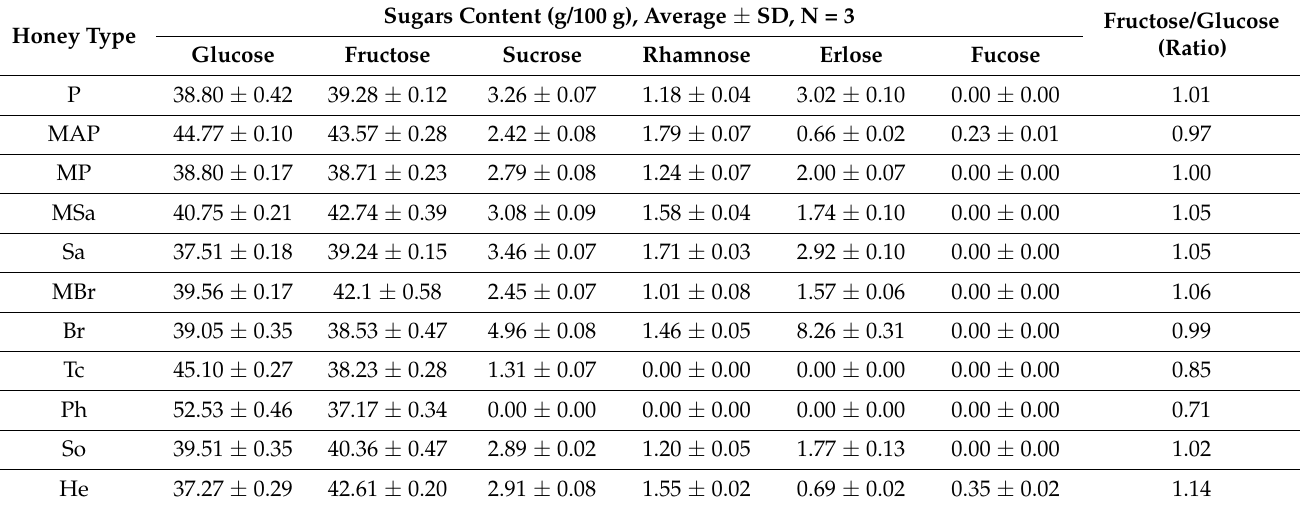
Table 2. Major sugar components in tested honey samples as determined by HPLC.